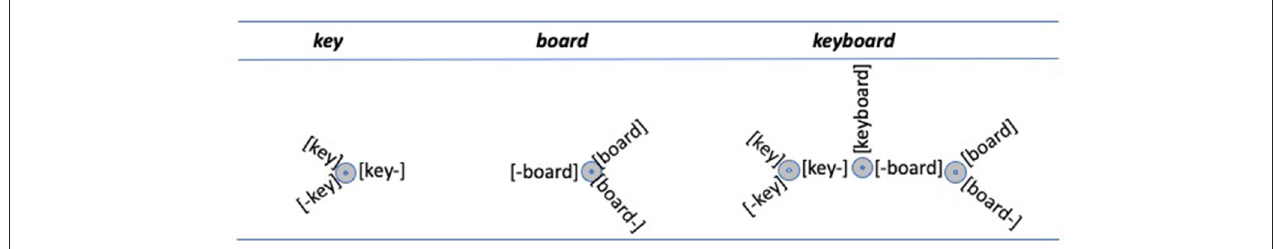
FIGURE 2 | Morphological transcendence creates a proliferation of lexical entities. The representations of key, board, and their combination in the compound